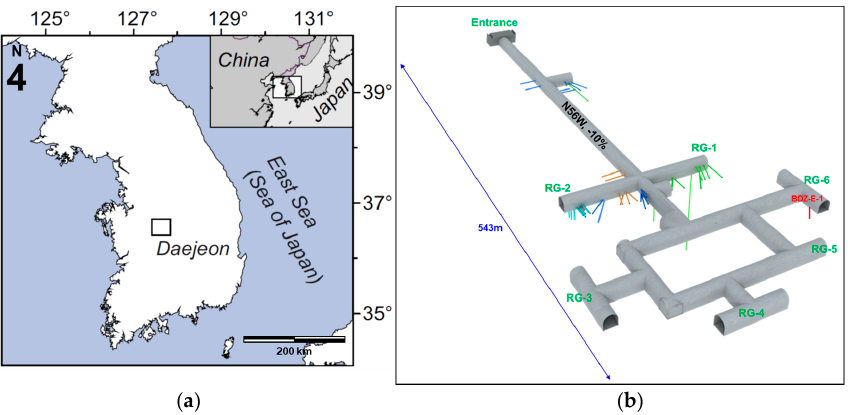
Figure 1. ( a ) Location; and ( b ) layout of the Korea Atomic Energy Research Institute (KAERI) Underground Research Tunnel (KURT). The test borehole, BDZ-E-1 is located at RG-6 in KURT.